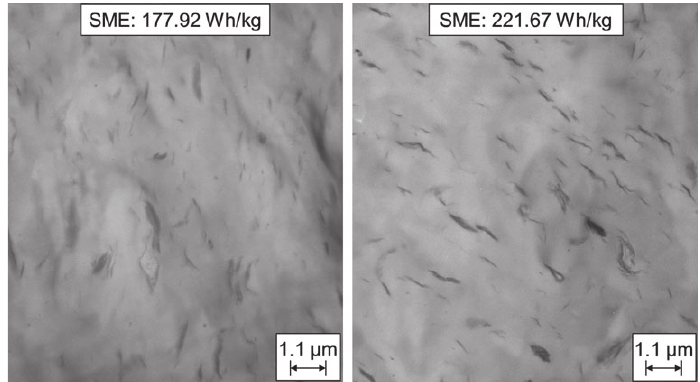
Figure 10 Dispersion of NC for two composites made with different SME using TEM.